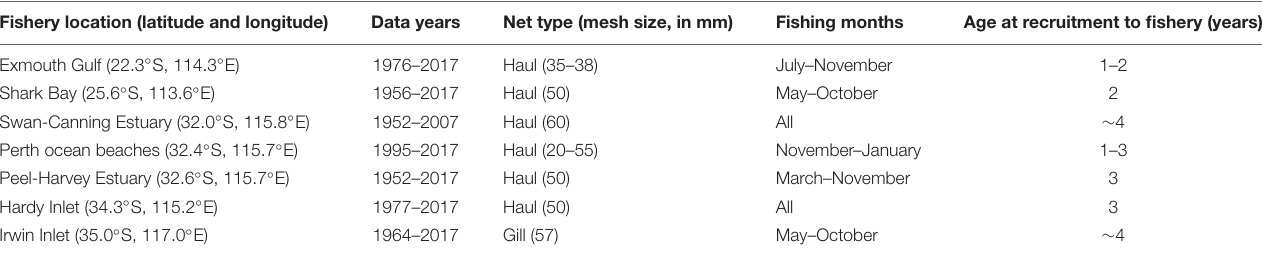
TABLE 1 | Location of commercial fisheries for which catch rates were examined, years for which annual catch and effort data are available, and the primary fishing gear and primary fishing months for capturing S. schomburgkii . Fishery location (latitude and